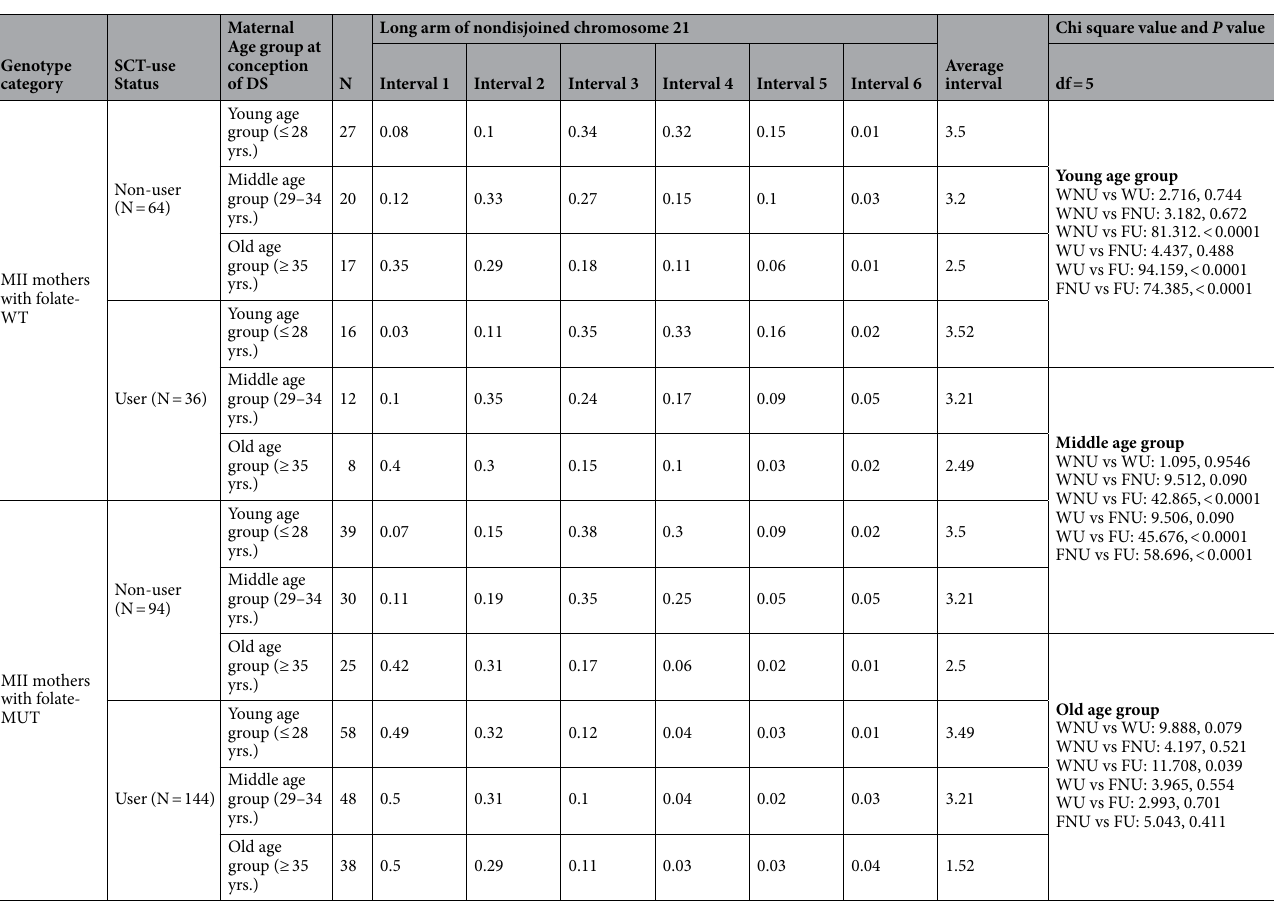
Table 6. Spatial distribution of single recombinant events on 21q among the case women stratified by genotype, SCT use status and maternal age at conception. Chi-square test for 6 × 2 contingency tables were performed to compare the frequency of position of single recombination events stratified by genotypes, SCT use status and maternal age within MII error group and P value < 0.05 was considered statistically